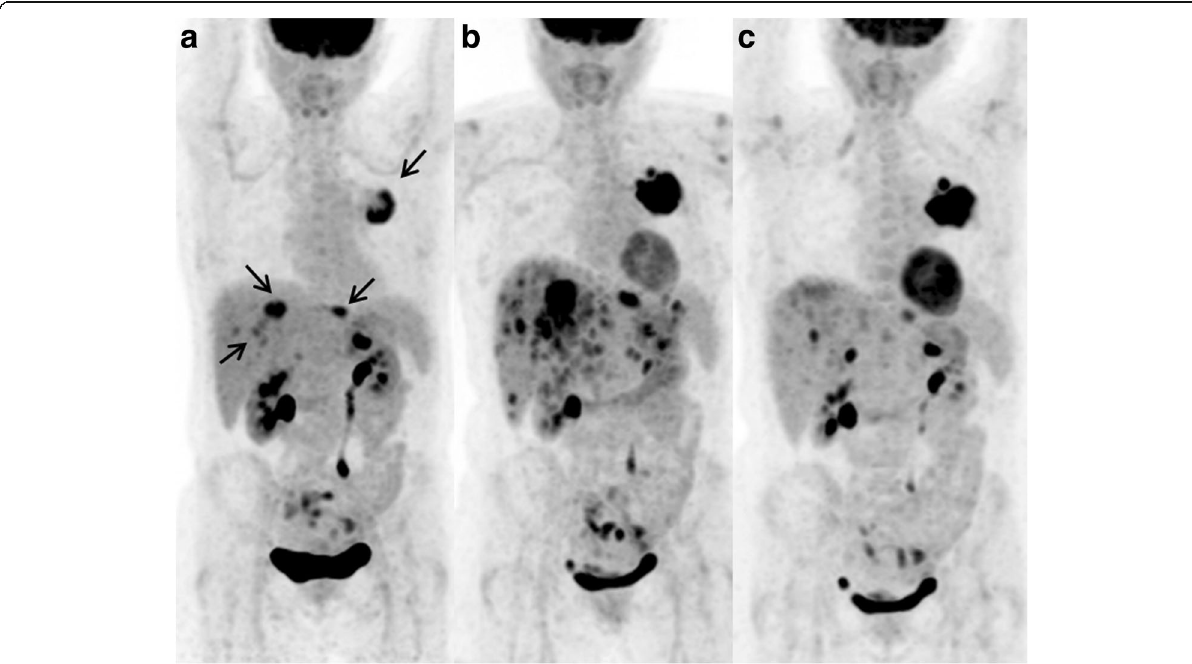
Fig. 3 A 45-year-old women with metastatic lymphoepithelioma-like lung carcinoma treated with a second line of nivolumab. SCAN-1 showed left lung carcinoma with liver metastases ( a maximum intensity projection image, MIP, arrows). SCAN-2 at 8 weeks of treatment (4 cycles) showed UPMD: increase in size of the primary lesion and appearance of numerous liver lesions ( b MIP). SCAN-3 after two more cycles of nivolumab showed the disappearance of most liver lesions and a persistent large lung mass ( c MIP). See Additional file 1: Figure S1 for axial views. Pseudo- progression was retrospectively diagnosed, and the classification was PMR according to iPERCIST. Nivolumab treatment was maintained for 7.1 months, and survival was 13.8 months